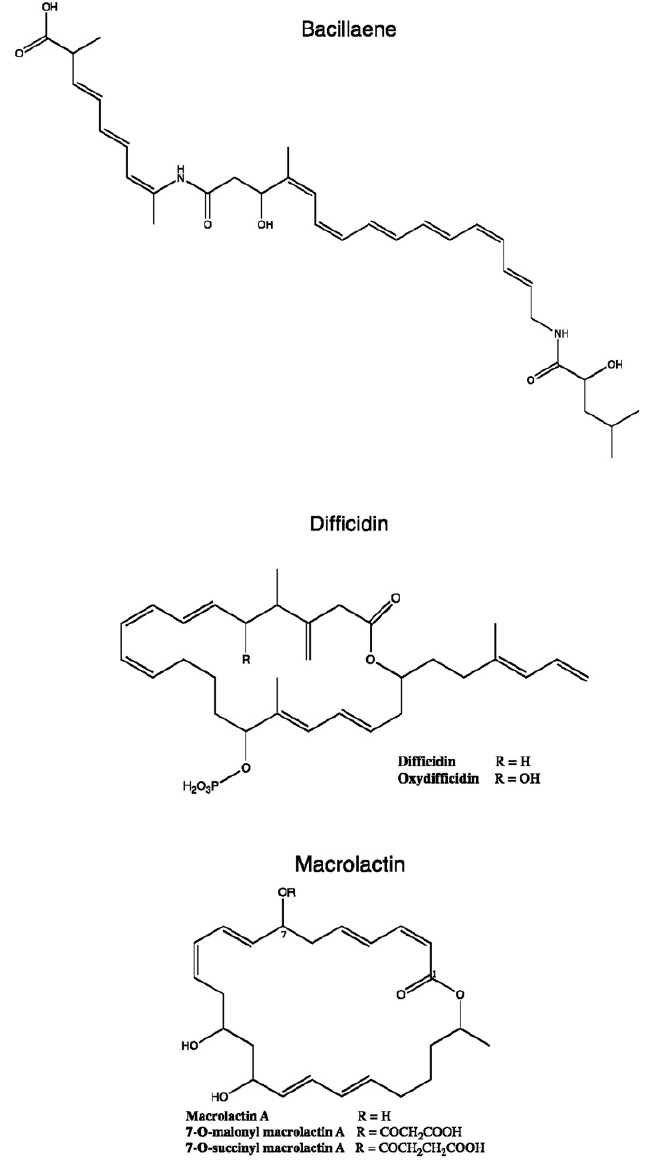
Figure 2. Chemical structures of bacillaene, difficidin and macrolactin.